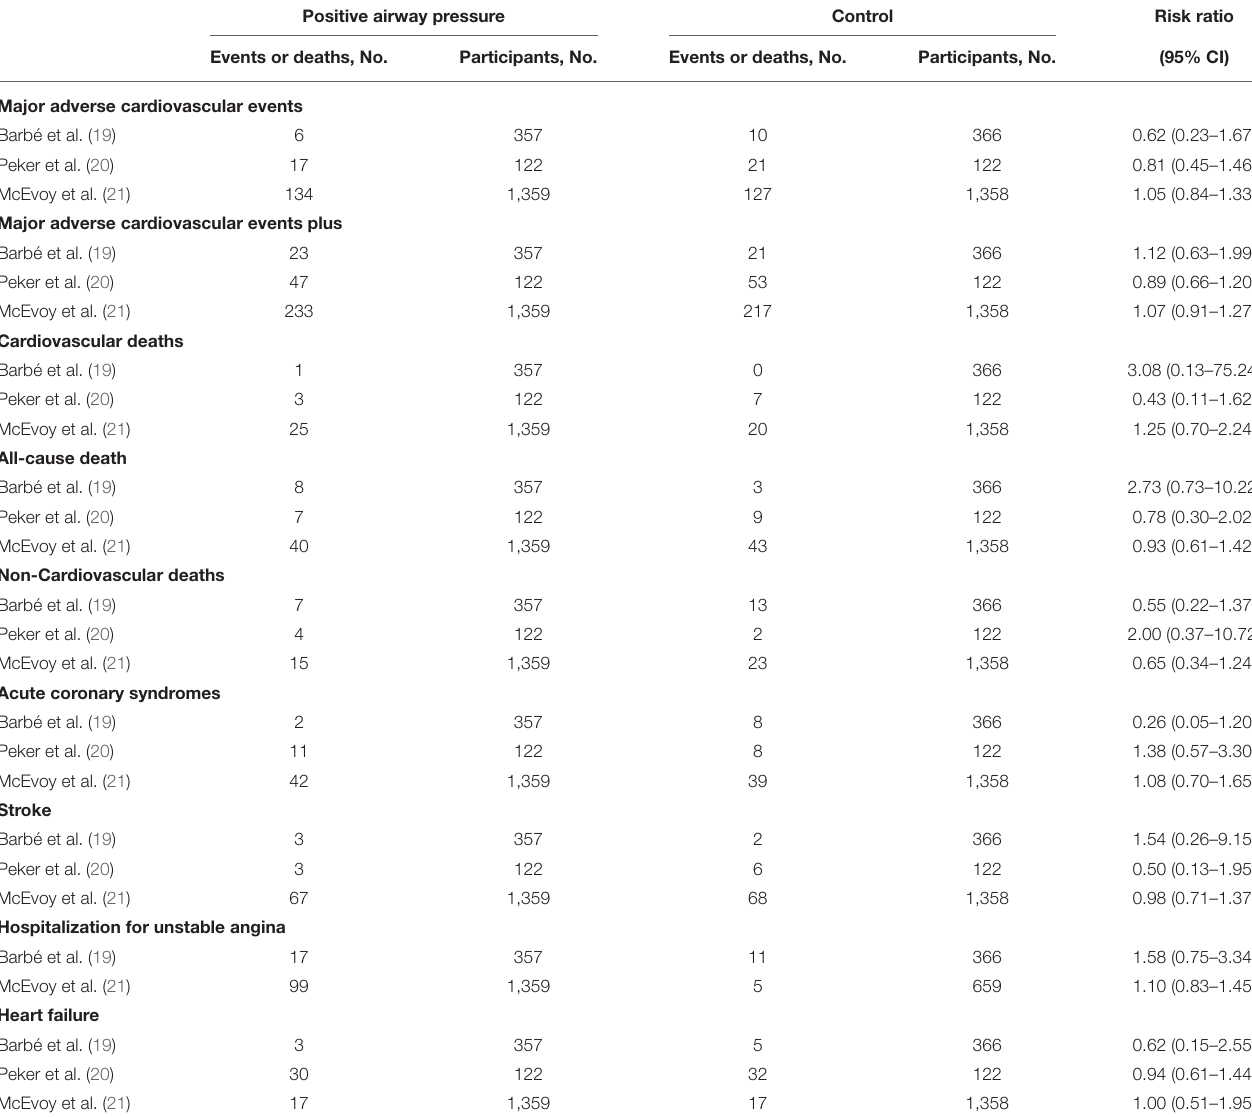
TABLE 1 | Association of positive airway pressure with cardiovascular events and deaths in the randomized clinical trials. Positive airway pressure Control Risk ratio Events or deaths, No. Participants, No. Events or deaths, No. Participants, No. (95%